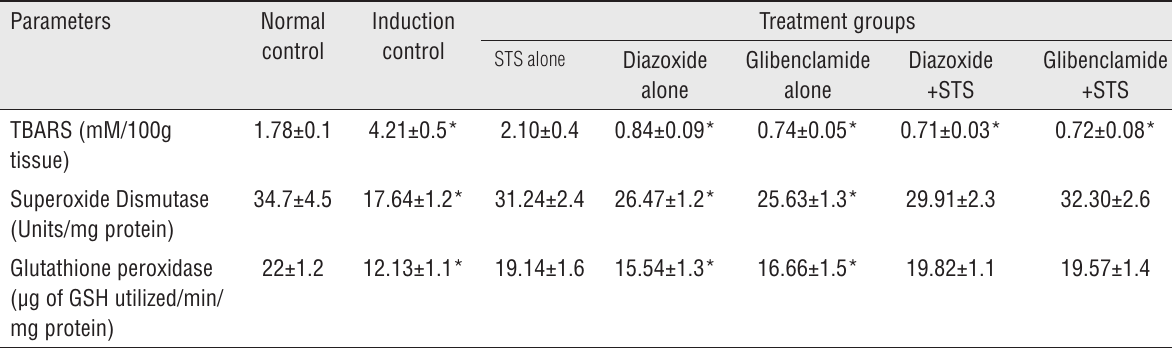
Table 3 - Lipid peroxidation and antioxidant levels. Parameters Normal